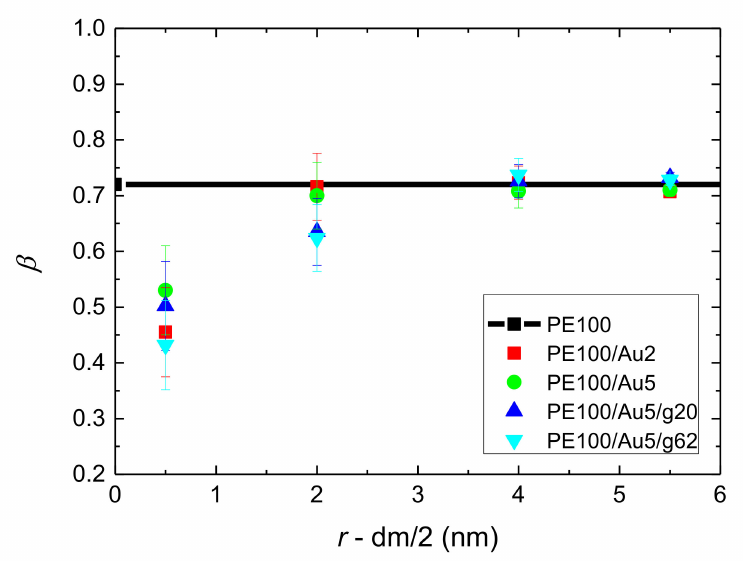
Figure A8. The stretch exponent β , as extracted from the fit of C 1–3 ( t ) ACF with a KWW, as a function of distance from the center of the Au NP, r , minus the half diameter of the NP, for all systems with PE matrices consisting of 100 mers per chain. Black lines represent β values of bulk